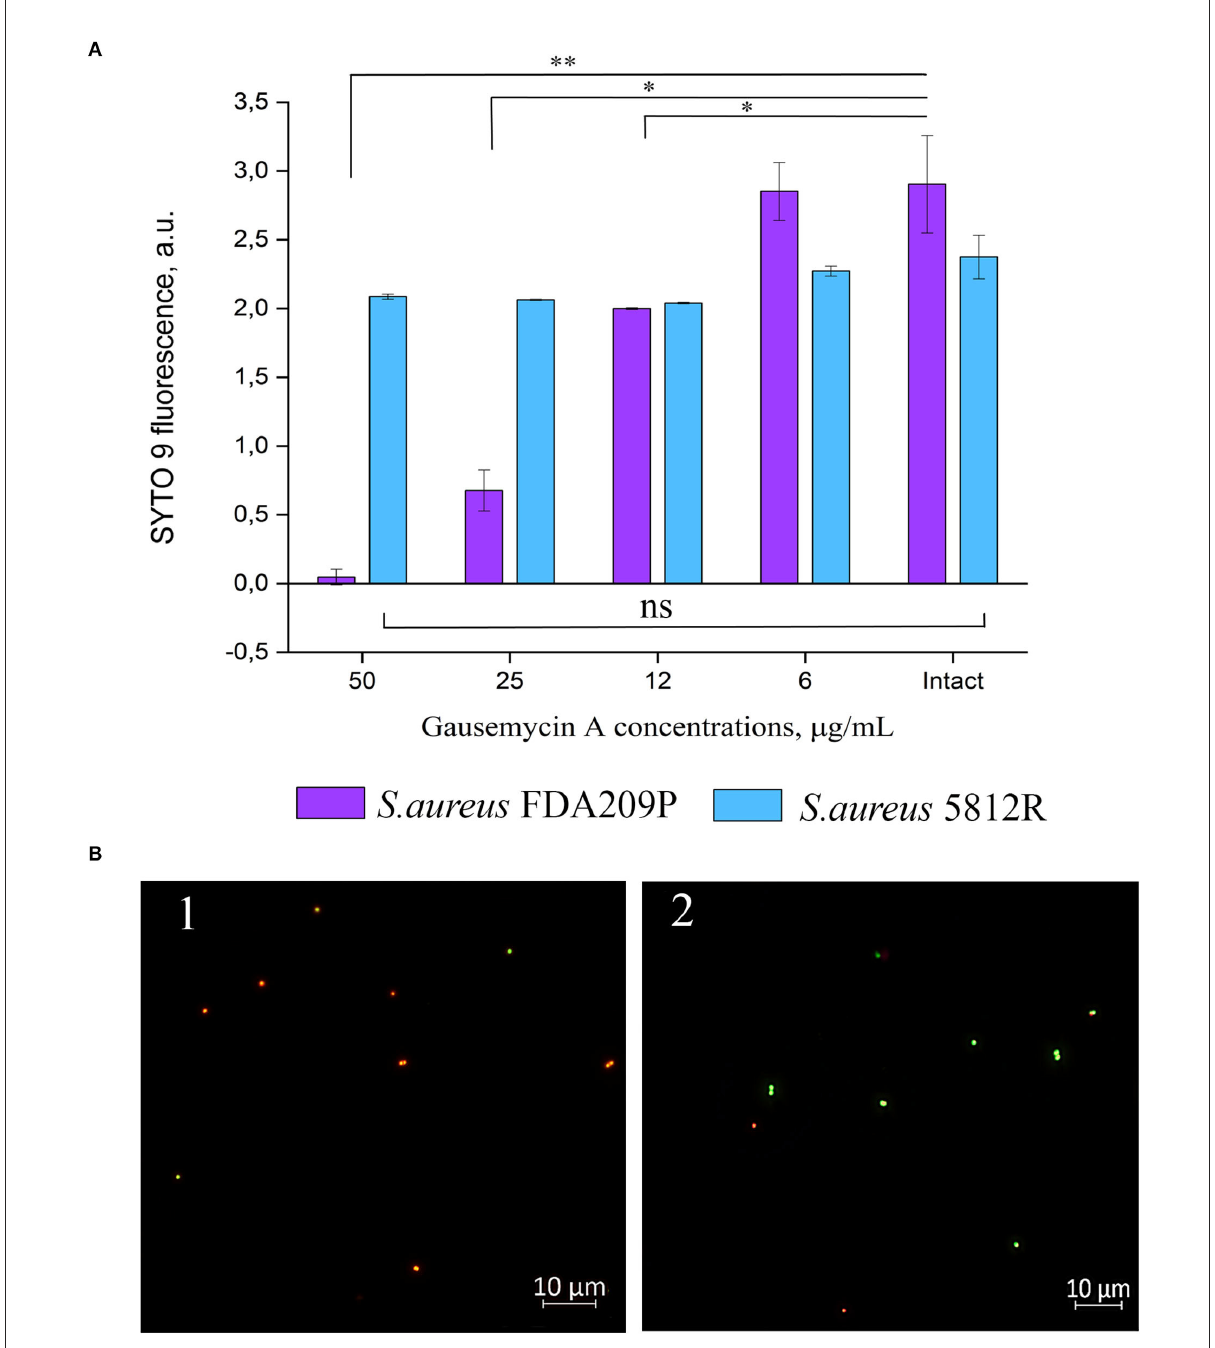
FIGURE2 The evaluation of membrane disturbance of S. aureus FDA209P and S. aureus 5812R using Live/Dead fluorescent dyes. The data show the intensity of SYTO 9 fluorescence at the end-point of measurement (10min) (A) . Epifluorescence microscopy images of S. aureus FDA209P (1) and S. aureus 5812R (2) after treatment with gausemycin A (B) . The means plus standard deviations of the means of results from two independent experiments with three technical replicates are shown (* p < 0.05, ** p < 0.01, ns—values are not significantly different).